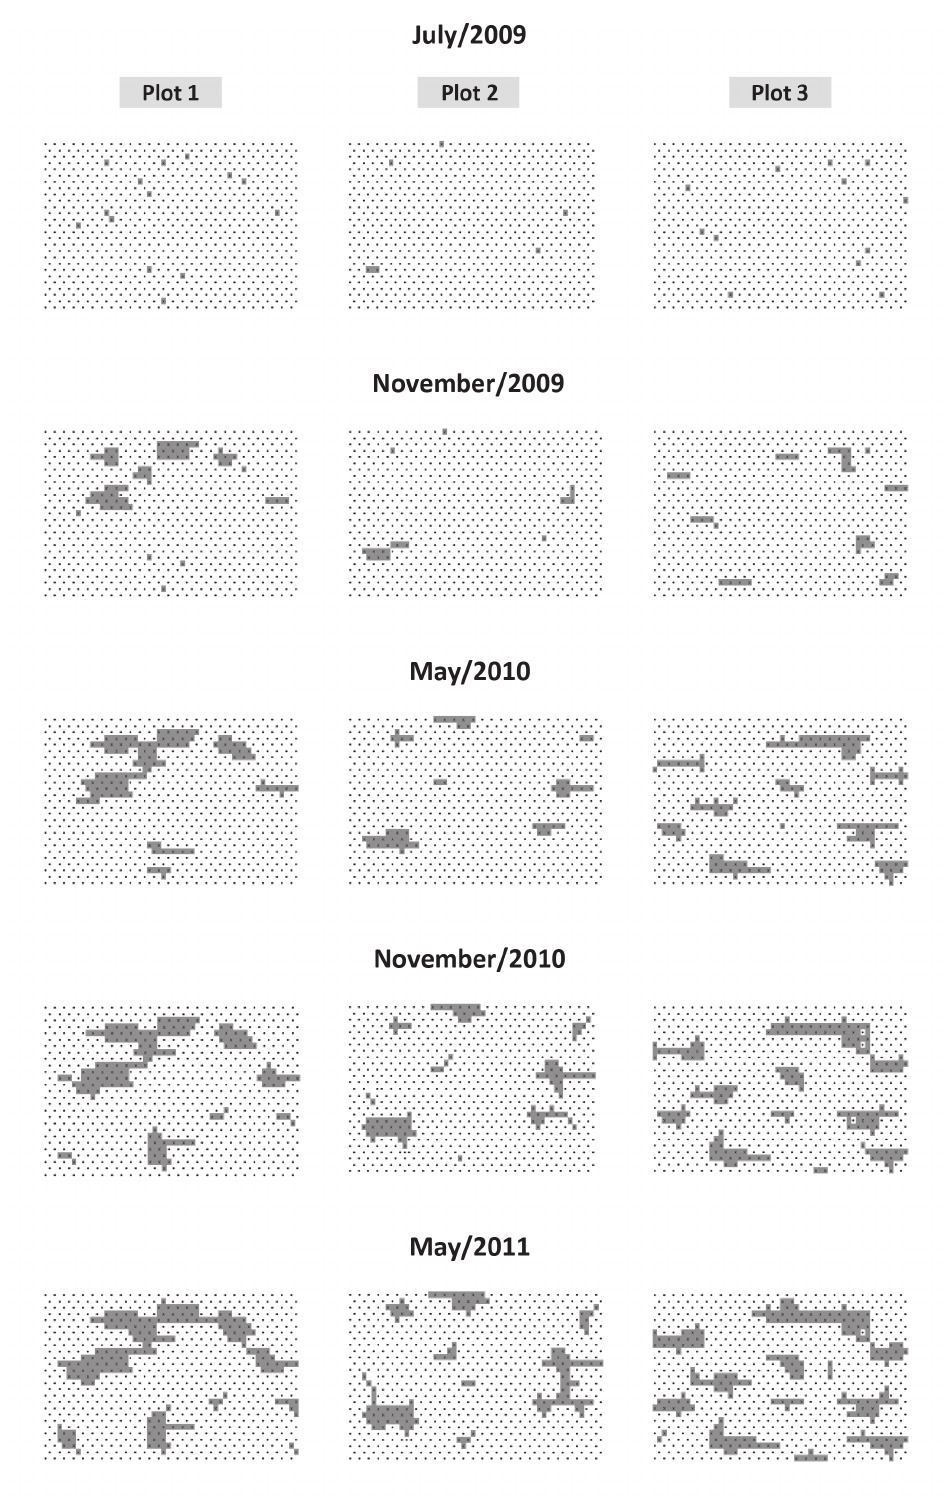
Figure 3 - Outbreaks of coconut stem bleeding detected by disease symptoms in the area of Neopolis, Sergipe,